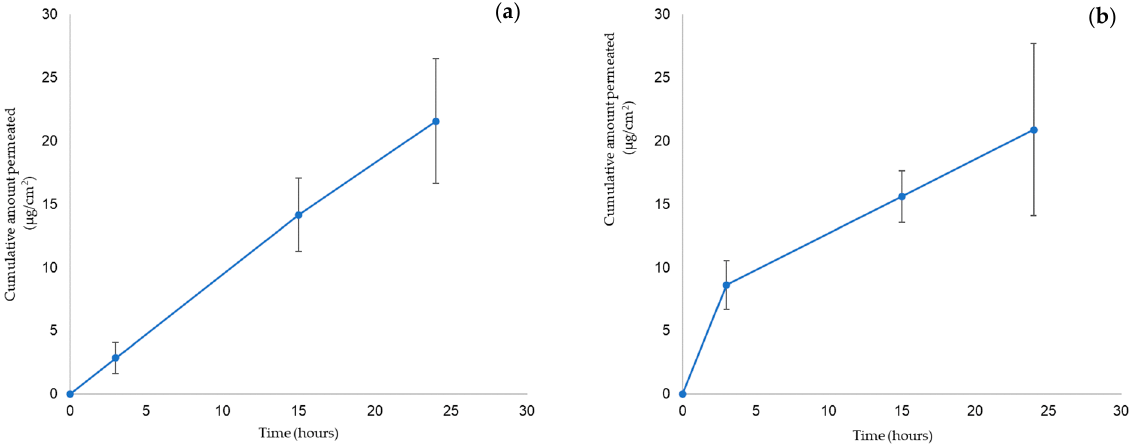
Figure 8. Corneal permeability of the transferosomes prepared with 1% of the edge activators ( a ) Span ® 80 transferosomes; ( b ) Tween ® 80 transferosomes.